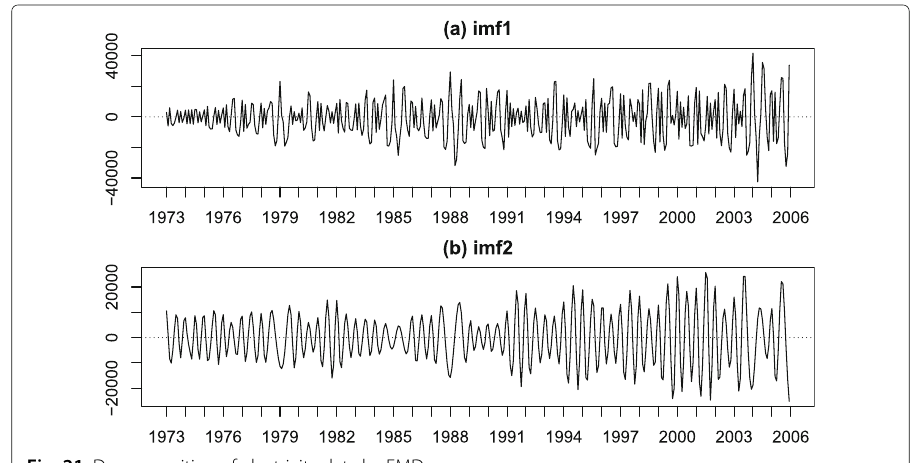
Fig. 21 Decomposition of electricity data by